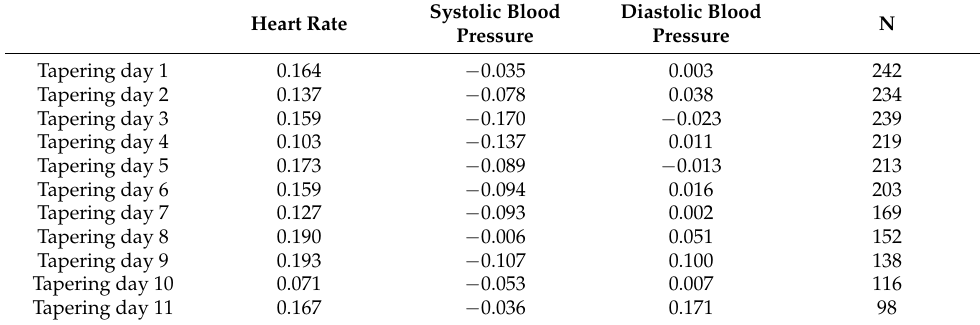
Table A2. Daily average subjective withdrawal symptoms correlated with